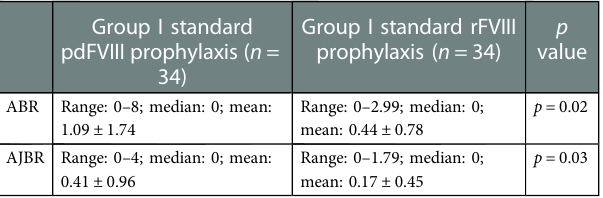
TABLE 3 Comparison of bleeding outcomes in patients on standard prophylaxis regimen, before and after FVIII product switch. Group I standard pdFVIII prophylaxis ( n =